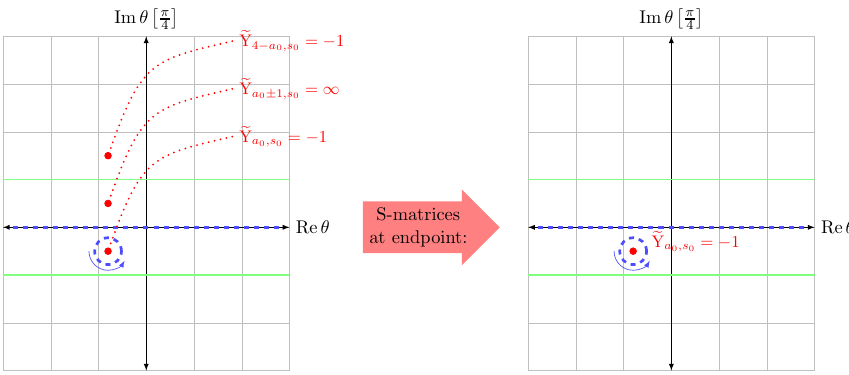
Figure 4 . Example of an analytic continuation in which only the first singular point of the diamond shown in figure 3 crosses the integration contour, while the other singular points remain above the integration contour indicated by the blue dashed line. The blue arrow indicates the orientation that the residue contribution of the crossing singularity is picked up with. The green solid line . Note that the locations of the singularities e Y 0 = ∞ are indicates the region − π ≤ Im θ ≤ π a 0 ± 1 ,s 0 4 4 within this region, but have not crossed the integration contour by assumption. At the endpoint, one S-matrix corresponding to the crossing singularity has to be taken into